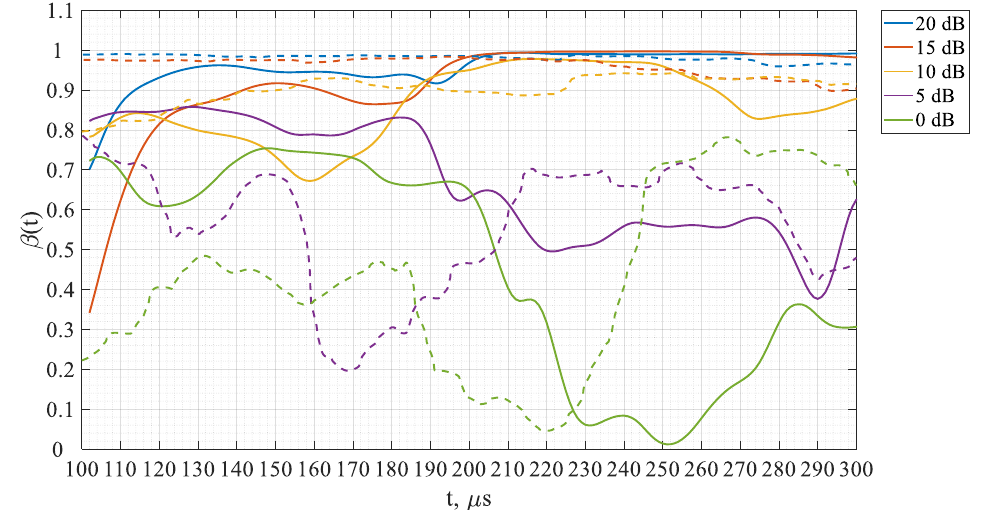
Figure 7. Hardware (solid lines) and simulation (dashed lines)-based results for the experimental study of the noise immunity of the RC2 chaos oscillator’s synchronization.